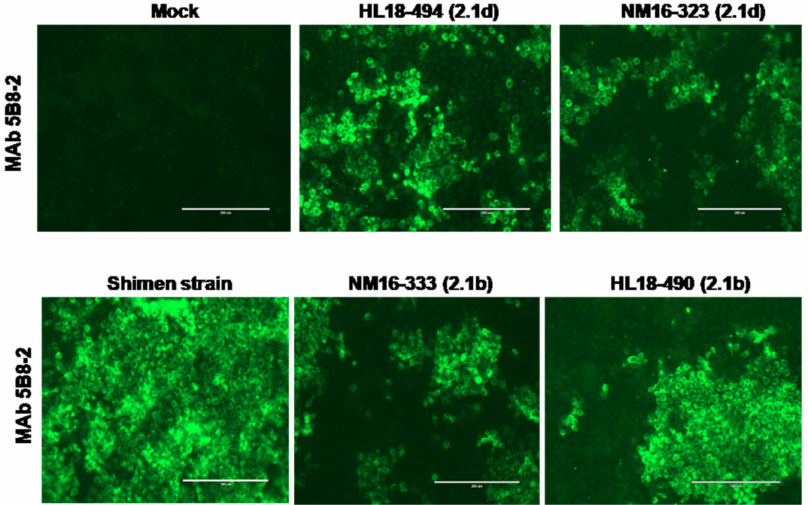
Figure 1. Confirmation of CSFV in PK-15 cells by IFA. The figure represented the reaction of anti-E2 MAb 5B8-2 with Shimen, NM16-323, NM16-333, HL18-494 and HL18-490 strains of CSFV. The scale bar is 200 µ